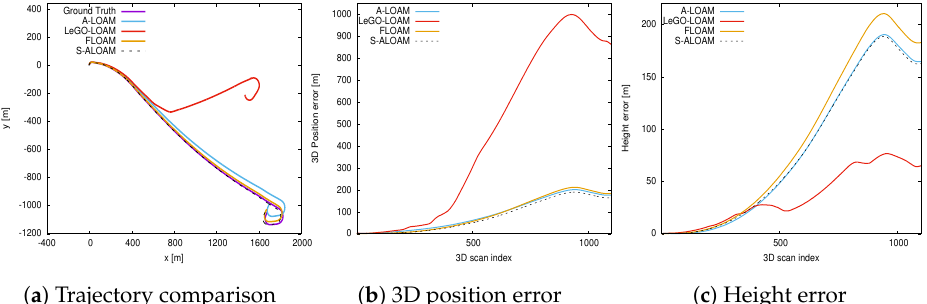
Figure 8. The trajectory comparison in Sequence 01. ( a ) The plot of the trajectories from different methods. ( b ) The absolute 3D translation error. ( c ) The absolute height error.